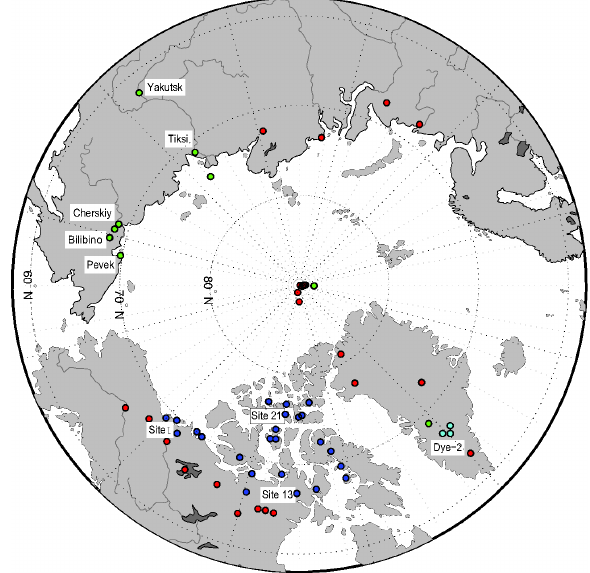
Fig. 1. Sampling sites for the 2008 (green dots) and 2009 data sets (blue dots) analyzed in this study, and for the 2007 data set (red dots) of Hegg et al.